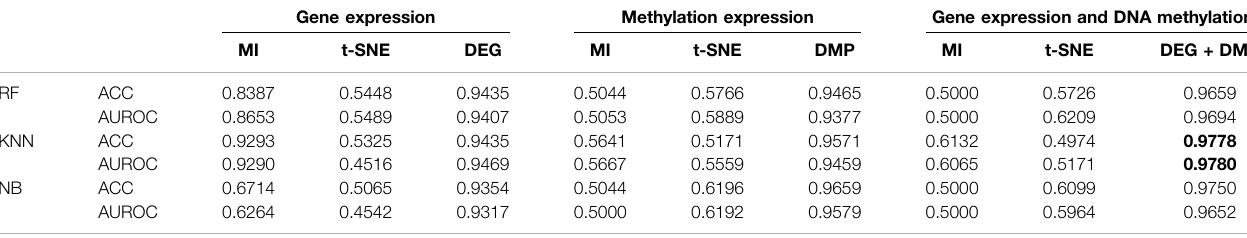
Methylation expression